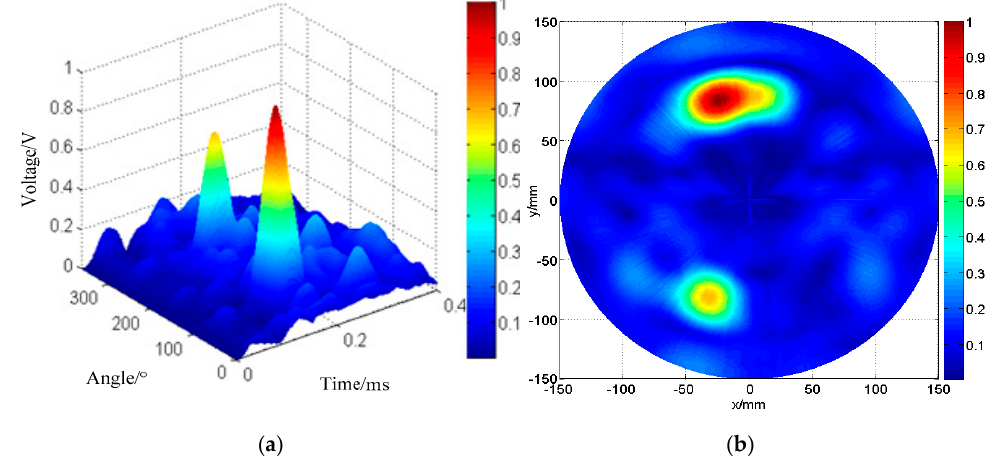
Figure 12. Damage imaging. ( a ) Angle-time-amplitude damage imaging ( b ) Cartesian damage imaging.